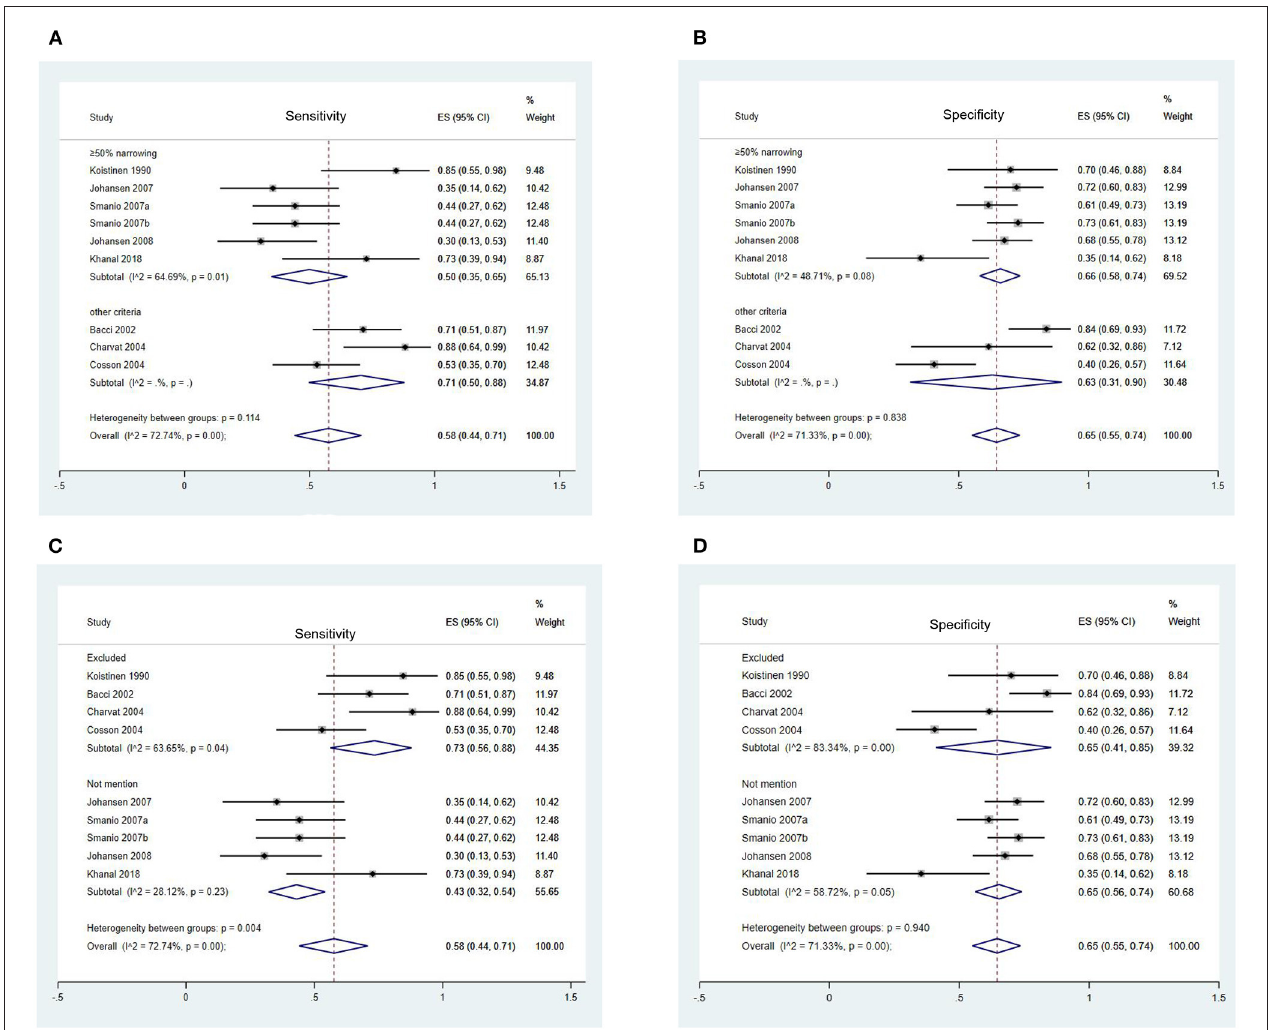
FIGURE 3 | Forest Plots of Sensitivity and Specificity of EST in Different Subgroups. (A) Forest plot of sensitivity of EST in different angiographic criteria of CAD; (B) Forest plot of specificity of EST in different angiographic criteria of CAD; (C) Forest plot of sensitivity of EST in different treatment equivocal or non-diagnostic test; (D) Forest plot of specificity of EST in different treatment equivocal or non-diagnostic